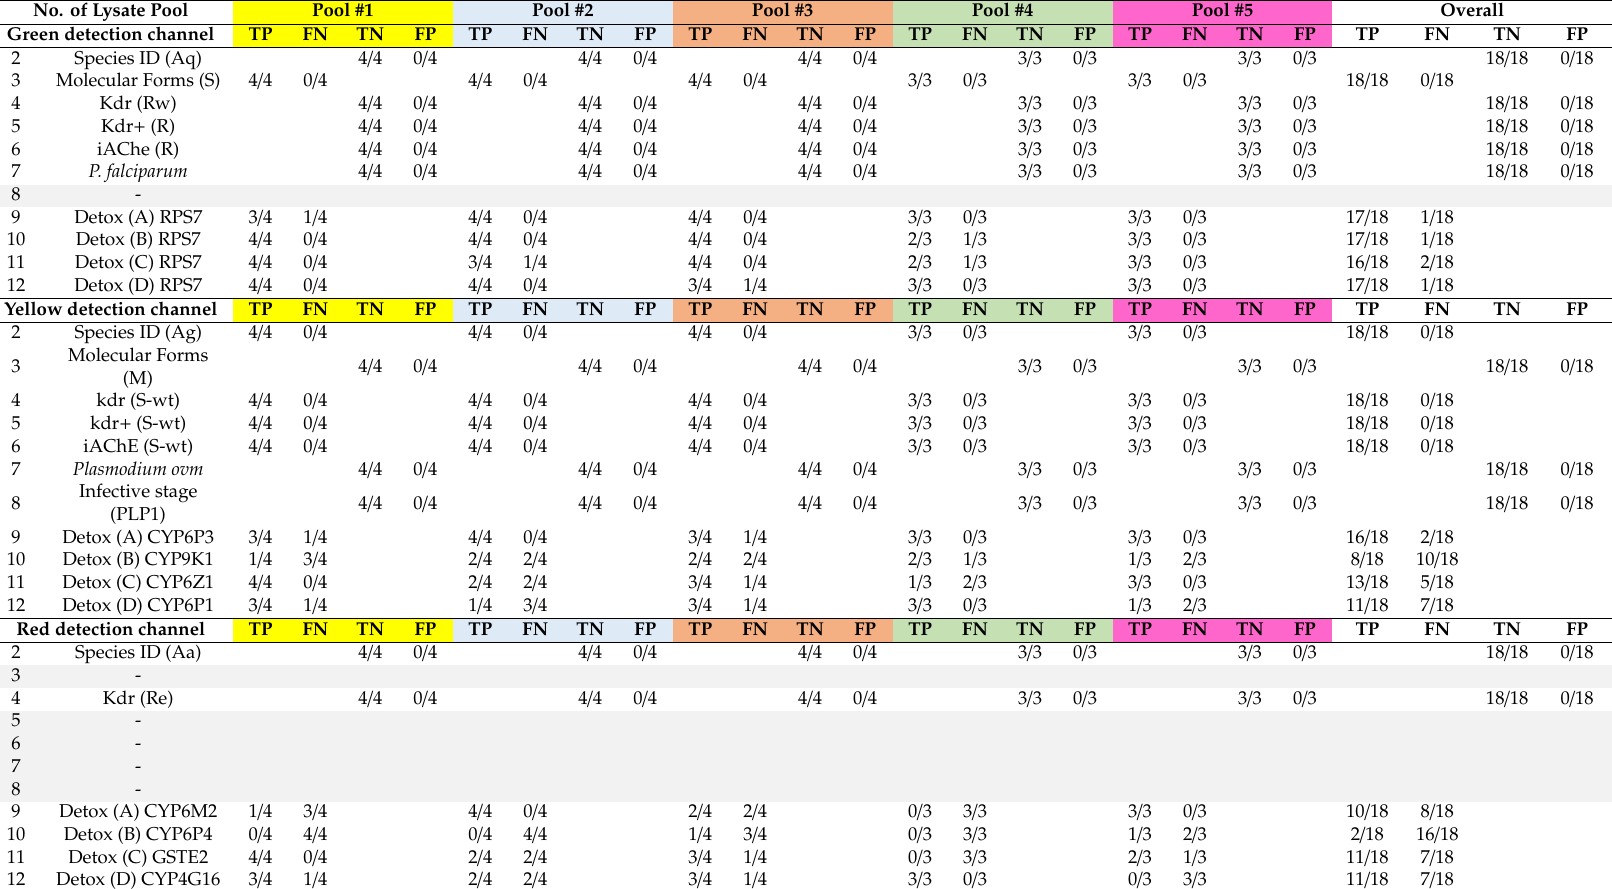
Table 3. Overview of the true positive (TP), false negative (FN), true negative (TN), and false positive (FP) rates for each assay and for each mosquito pool, as well as in total for the Vector Study. The five di ff erent colors (Pool #1 ... #5) refer to the five di ff erent pools of mosquitoes (Figure 1). The numbering in the first column indicates the VectorDisk reaction chamber where an assay is expected positive or negative. The grey horizontal shading in some assay rows (accompanied by the symbol ‘-’) means that neither positive nor negative signal was expected, because the primer / probe mixtures stored in these chambers were expected to give signals in other detection